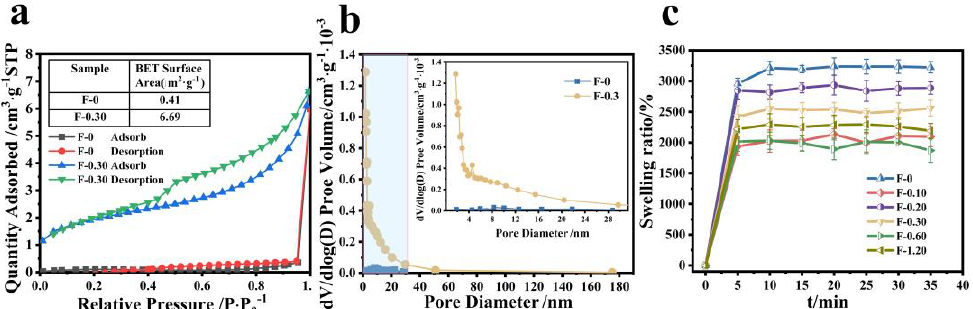
Figure 8. ( a ) The specific surface area of F-0 and F-0.3, ( b ) the pore size distribution of F-0 and F-0.3, and ( c ) the swelling rate of the samples. Reaction conditions: distilled water (30 mL), composite membrane (0.1 g).